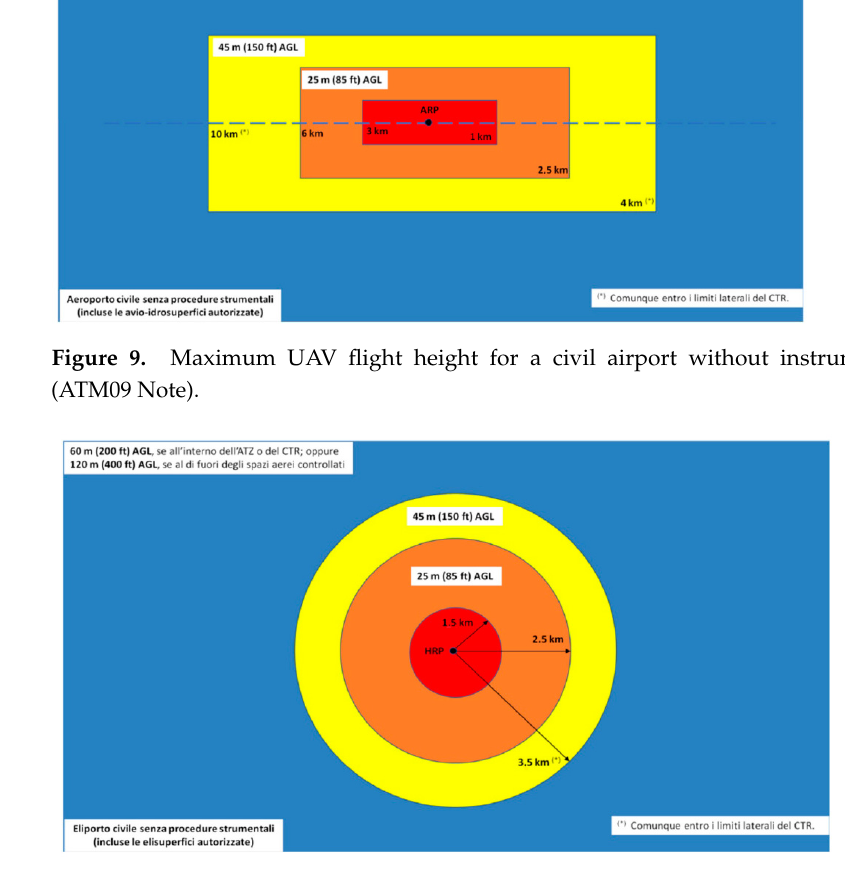
Figure 10. Maximum UAV flight height for a civil heliport without instrumental procedures